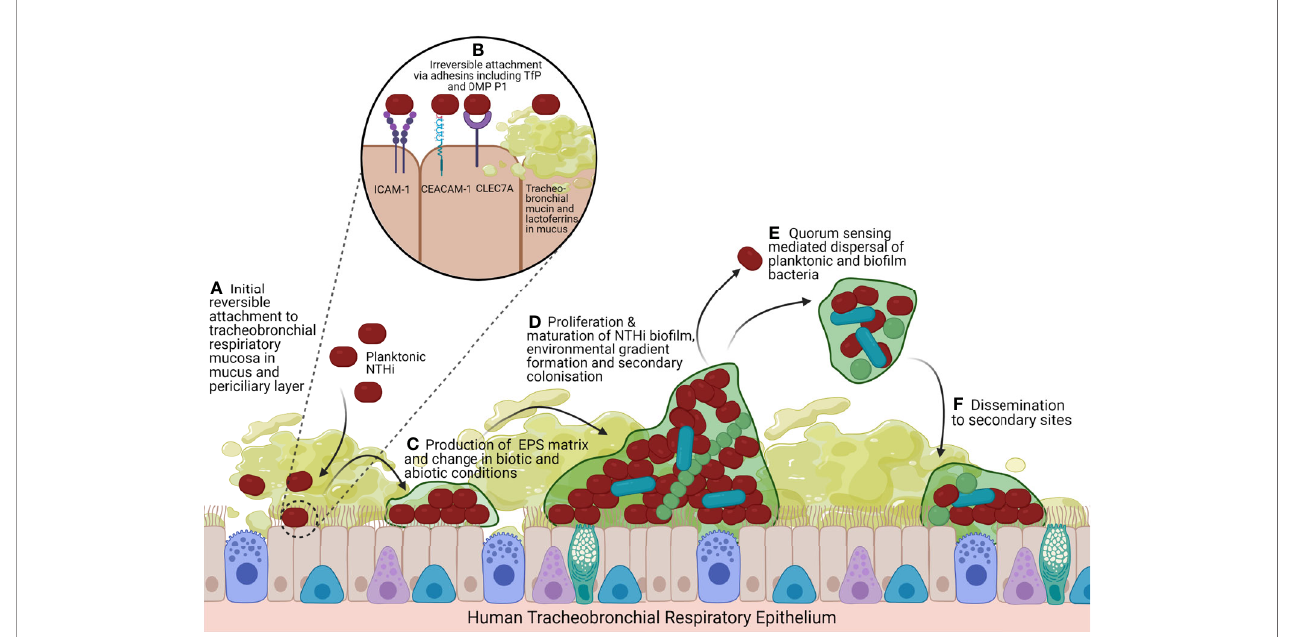
FIGURE 1 | Model of NTHi Bio fi lm Formation and Lifecycle. (A) The impaired mucociliary clearance system coupled with in fl ammatory mucus secretion hyperplasia creates a suitable substrate for the initial colonisation and reversible attachment of NTHi to the air-liquid interface of the tracheobronchial respiratory mucosa, a pseudostrati fi ed, ciliated, columnar epithelium predominated by ciliated epithelial cells and interspersed by secretory cells (mucus-secreting goblet cells and secretoglobin secreting club cells) and basal cells. In COPD disease states, the mucus layer extends into the periciliary layer. (B) NTHi irreversibly attach to respiratory epithelial cells by adhesins including Type IV Pilus and OMP P1 that bind ICAM-1, CEACAM-1 and CLEC7A. NTHi also binds to the mucus layer itself by having adhesins that bind tracheobronchial mucins and lactoferrins. (C) Irreversibly attached NTHi begin to aggregate and produce an EPS matrix, favouring secondary colonisers. (D) Bio fi lms exhibit complex intraspeci fi c and interspeci fi c interactions, signalling, metabolism changes, gene expression changes that drive nutrient and oxygen gradients. This leading to differentiation of bacteria and maturation of the bio fi lm with structurally large microcolonies with nutrient and water channels. (E) Quorum sensing changes drive dispersal of the bio fi lm as planktonic bacteria and aggregates of bio fi lm leading to (F) dissemination and colonisation of secondary sites, facilitating persistence. Created with